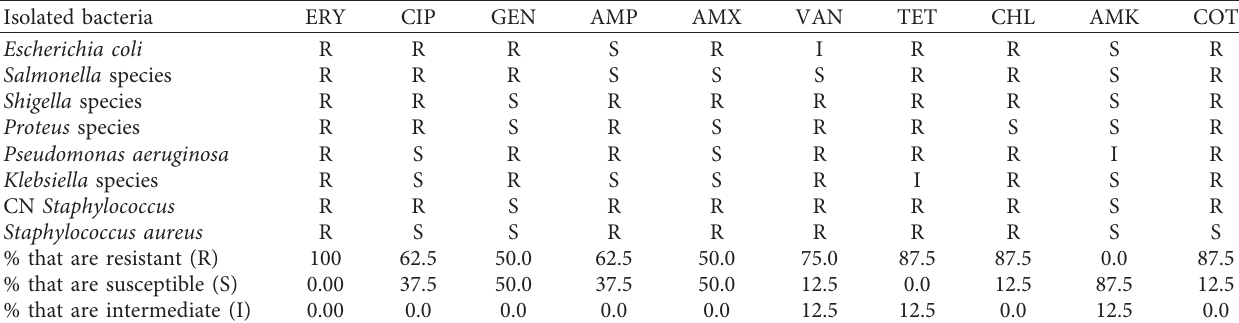
Table 4: Antibiotic sensitivity patterns of bacterial isolates from Ghanaian currency paper notes.